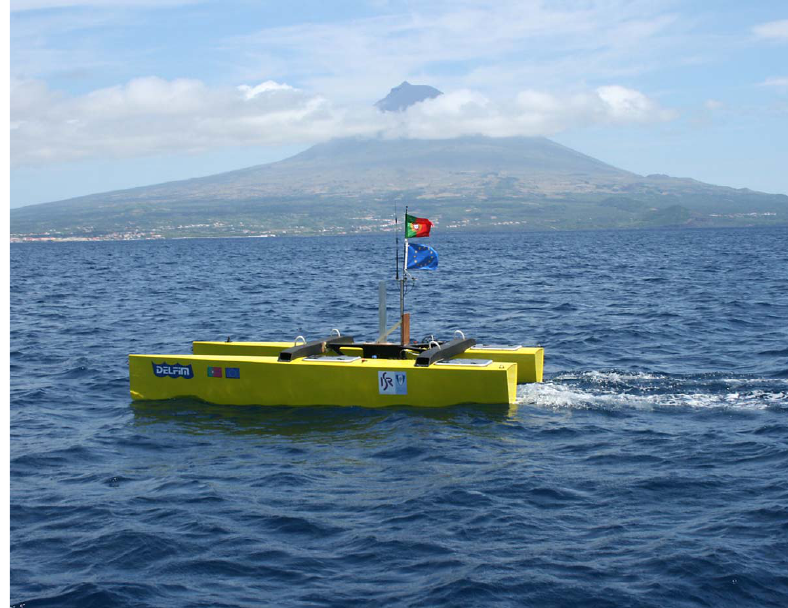
Figure 14. The DELFIM x ASV.